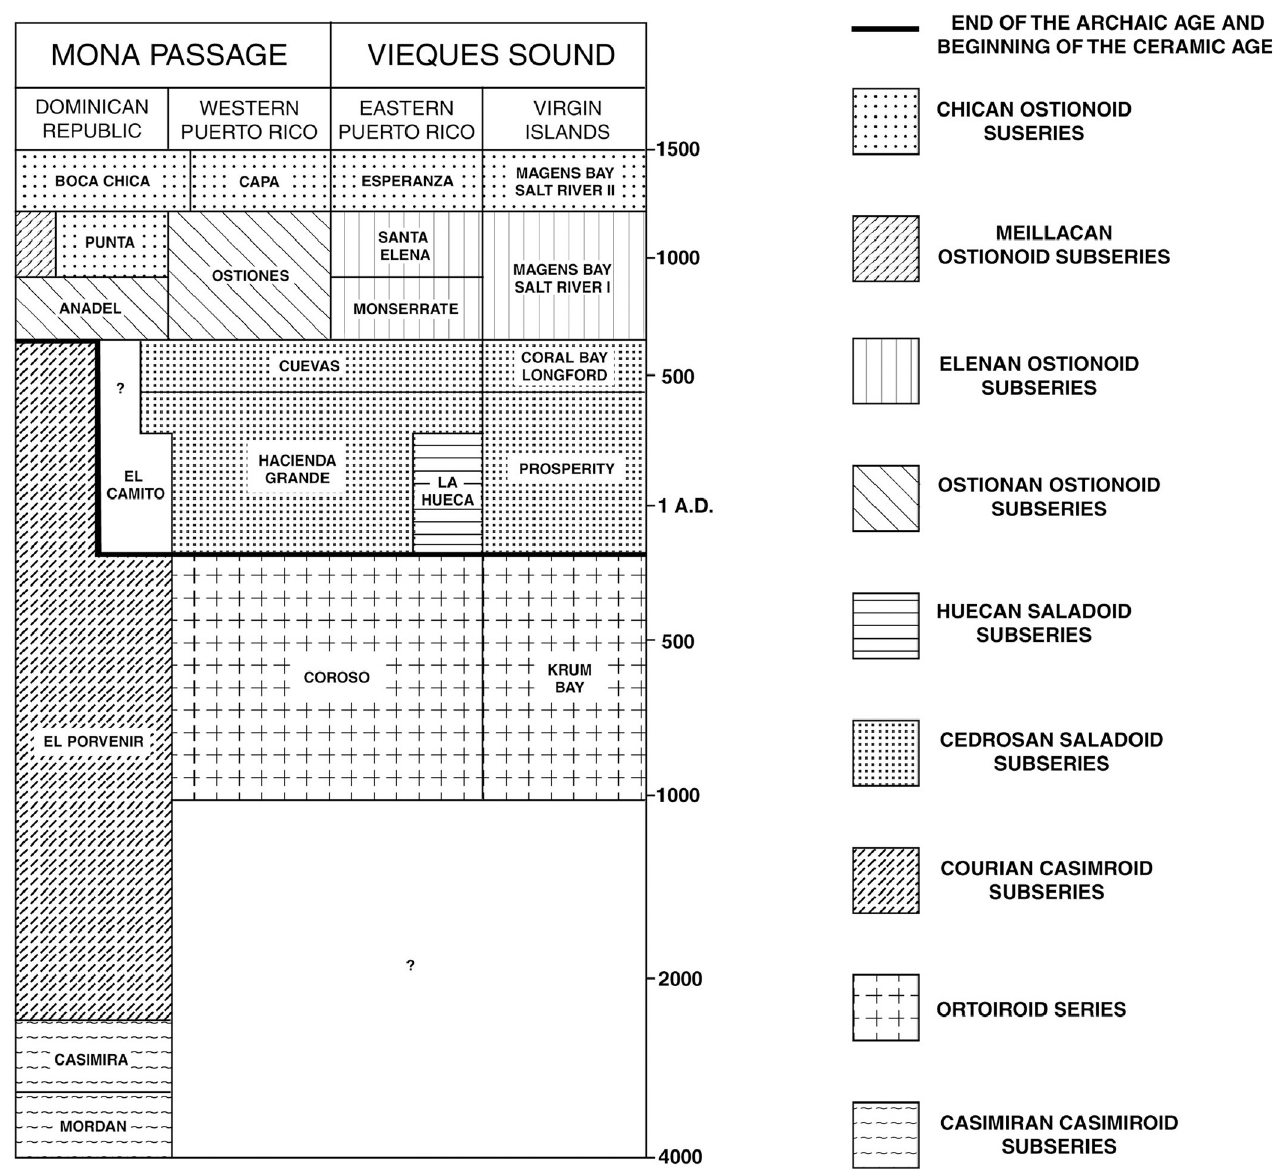
Fig 2. Rouse’s culture-chronology scheme for Puerto Rico. For explanation of categories/terms, see section below entitled, “A brief history of time in Puerto Rican archaeology”. Drawn by Jill Seagard, after Rouse [4].